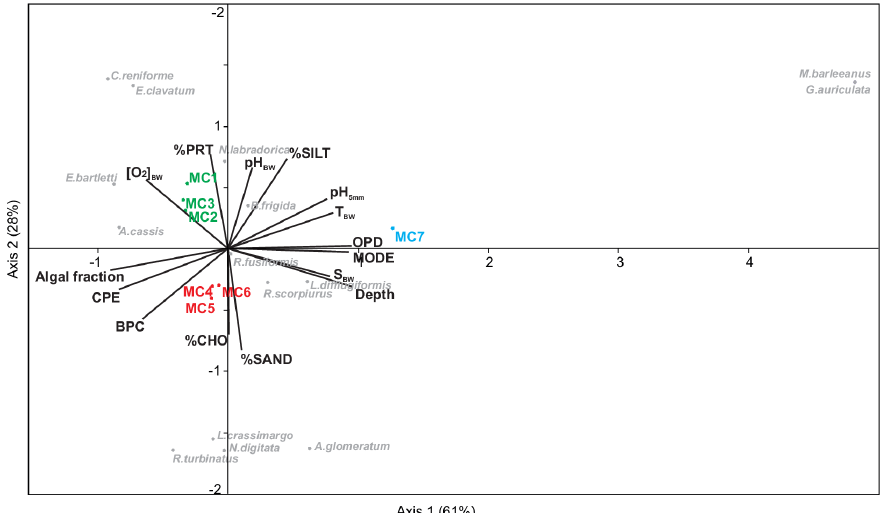
Figure 5. Canonical correspondence analysis based on real abundances (ind. 50cm − 2 ) of the living fauna in the 0–5cm sediment layer ( > 150µm size fraction) considering the major species ( > 5%) vs. environmental variables described in Tables 1, S1 and S2.